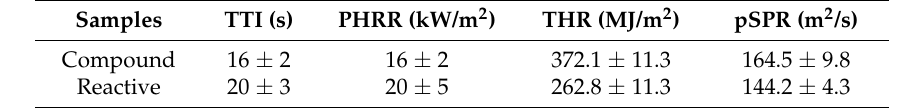
Table 4. Cone calorimeter data of EPDM/PP filled with 25 wt % compound and reactive MP/PER masterbatches.